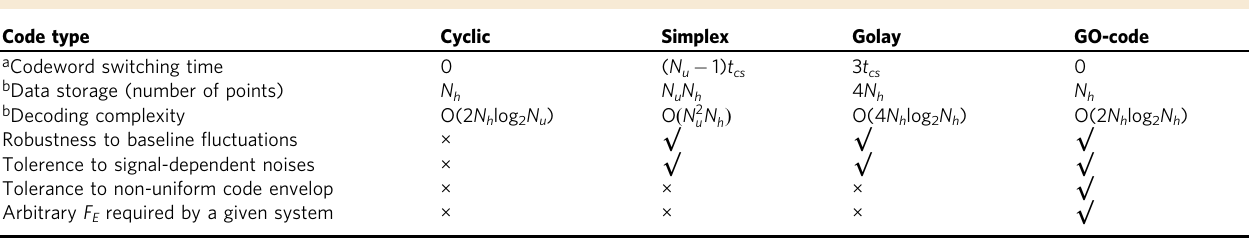
Fig. 5 Experimental results of on-line real-time measurement for the temperature of water under heating. a 2D map of the retrieved temperature as a function of time and fi bre position. For the sake of clarity, the fi gure only shows fi bre positions from 10.12 – 10.2 km. b Evolution of the retrieved temperature at the hotspot. c Error on the retrieved temperature at the hotspot as a function of time, obtained by subtracting the temperature measured by a thermometer to that from a single-pulse scheme (blue) and GO-coded scheme (red), respectively. Table 3 Performance comparison of different code